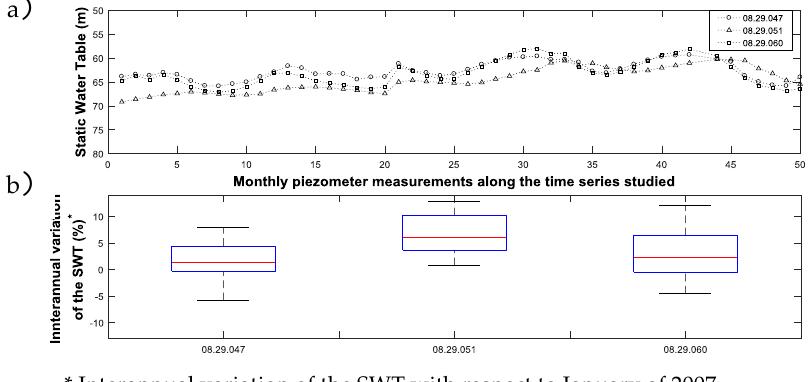
{ PAGE } * Interannual variation of the SWT with respect to January of 2007 Figure 6. Static water table ( a ) and monthly interannual variation ( b ) for each piezometer in WUA C. In Table 4, the DWT for each analyzed case and irrigation season is shown for each of the selected piezometers. In addition, during each irrigation season, the average values of the DWT for each case, along with the coefficient of variation (CV) for each one, is shown. Regarding the CV, it can highlight the low variability of the DWT, considering the selected months for each analyzed case. For each one of the selected piezometers, the high interannual variation of the DWT can be highlighted. This fact is important because it allows for a wide range of DWT values for each WUA, which is useful for validating the behavior and performance of the developed tool under different dynamic water table levels. Moreover, the selected piezometers show similar tendencies of decreasing the DWT level for the 2011 irrigation season. This fact is explained by the increasing energy tariffs during that period, which resulted in a reduction of the use of groundwater resources in these areas, thereby contributing to the recovery of the aquifers. Hence, several values for the DWT have been used in these WUAs, which are representative of the DWT levels in the Castilla–La Mancha region. 3.3. Energy Analysis For each analyzed well of each WUA, the irrigation season with the highest DWT value and the last irrigation season whose DWT values are available were chosen for the energy analysis. The DWT levels in Case 3 for the three WUAs analyzed were very similar. Therefore, only Case 1 and Case 2 were considered for the energy analysis of the three WUAs studied. Consequently, for each WUA studied, two irrigation seasons and two cases (Case 1 and Case 2) were considered in this analysis. The irrigation seasons with highest DWT values and the last irrigation season with available data for WUA A, B, and C were 2008, 2007, and 2007; and 2015, 2015, and 2013, respectively.